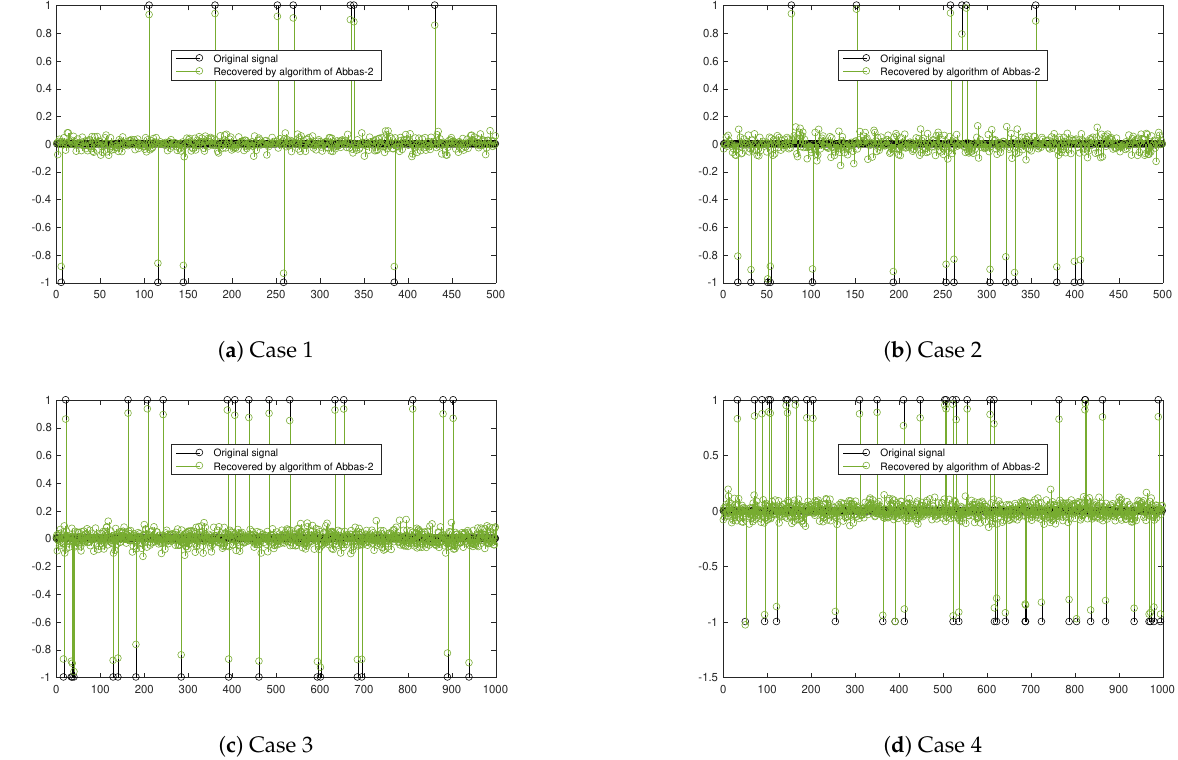
Figure 11. Recovery result by using algorithm Abbas-2 (18) in Example 2.